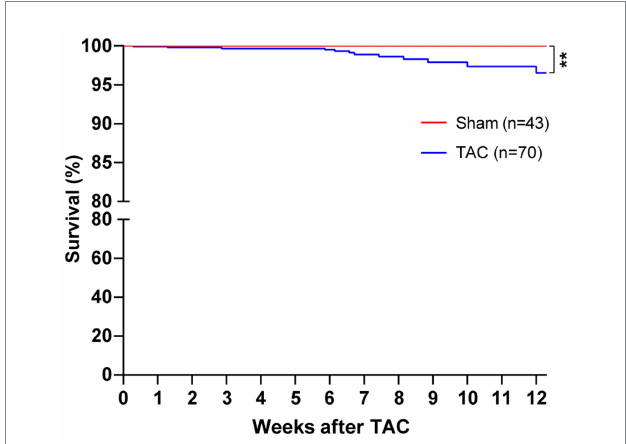
FIGURE 5 Survival of mice after TAC surgery. C57BL/J mice were randomized to TAC with a 25-gauge needle or sham surgery. The survival of mice was monitored for 12 weeks after surgery. Log-rank (Mantel–Cox) test and Gehan–Breslow–Wilcoxon test were performed for the survival rate of mice after TAC. ** p < 0.01 vs. Sham.